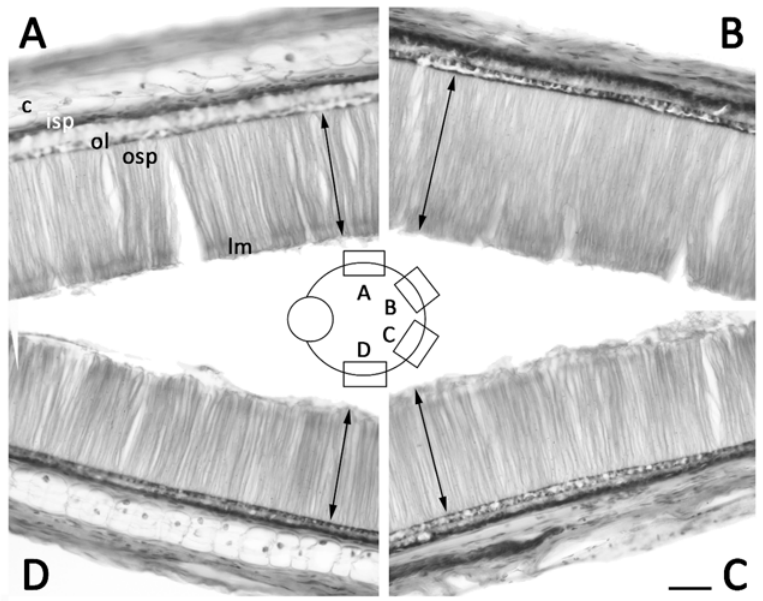
Fig 4. Cross-section at the equator of adult (ML 130 mm) T . pellucida retina showing no migrated ommin in any region and peripheral-central changes in photoreceptor thickness. Scale bar is 100 μ m. Arrows indicate length of outer photoreceptor segment. Abbreviations as in Figs 2 and